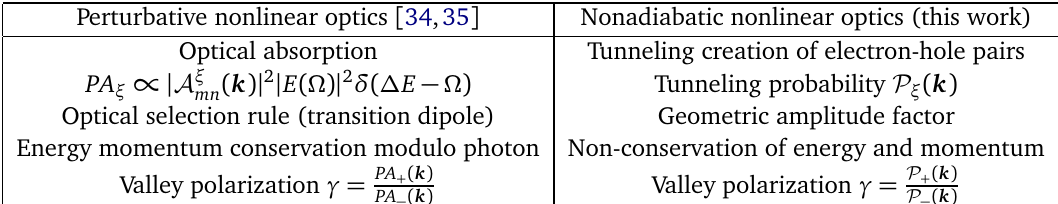
Table 1: Perturbative versus Nonadiabatic opto-valley